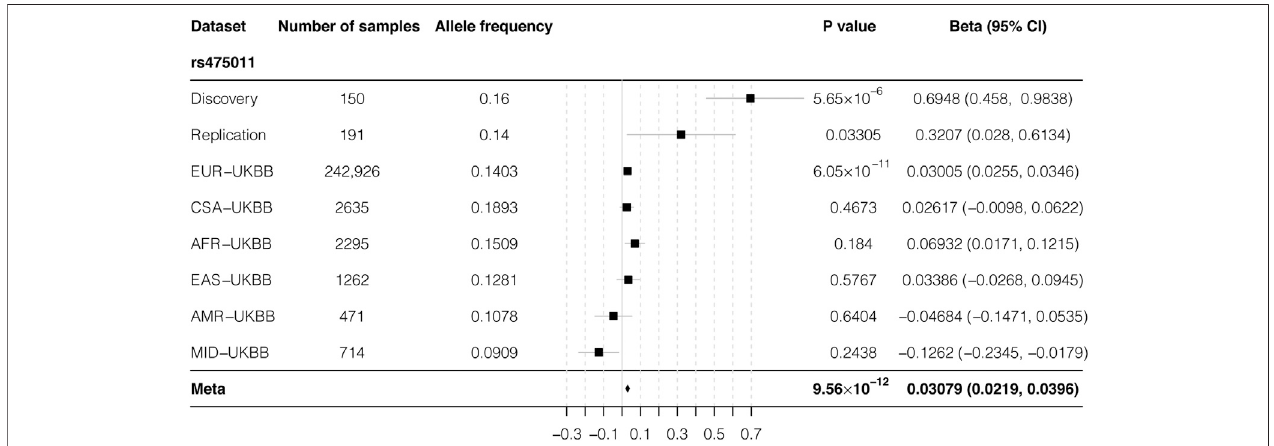
FIGURE 3 | Forest plot of meta-analysis result of rs475011. By combining result from our samples with UKBB summary statistics, a signi fi cantly association betweenrs475011andT-scorewasobtained( p (cid:1) 9.56 × 10 − 12 ,beta (cid:1) 0.0308).Samplesizeofeachancestryandanalysisgroupislistedontheleftofthe fi gureandthe associationresultsarelistontheright.X-axisrepresentsthebetavalueandY-axisrepresentsthesixancestrygroupsfromUKBBandthediscoveryandreplicationgroup ofourstudy.UKBB ancestry groupsarerankbythesamplesize.Thepositionofthesquare isthepointestimationofthebetavaluefromeach group.Thediamond represents the combined results. The width of the diamond indicate the 95% con fi dence interval. UKBB: UK biobank; EUR: European ancestry; CSA: Central/South Asian ancestry; AFR: African ancestry; EAS: East Asian ancestry; AMR: Admixed American ancestry; MID: Middle Eastern